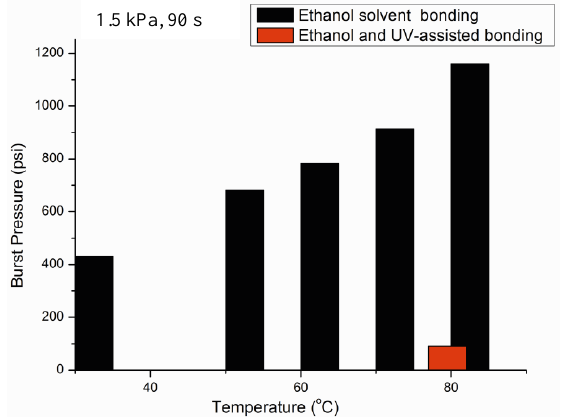
Figure 15. The effect of bonding temperature on burst pressure strength for ethanol bonded substrates